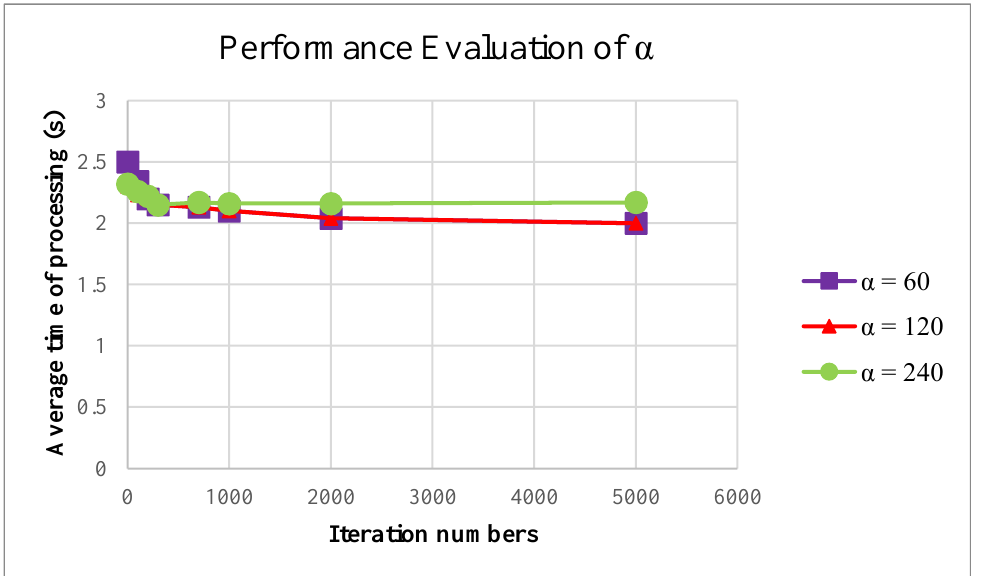
Figure 10. Performance evaluation of various α